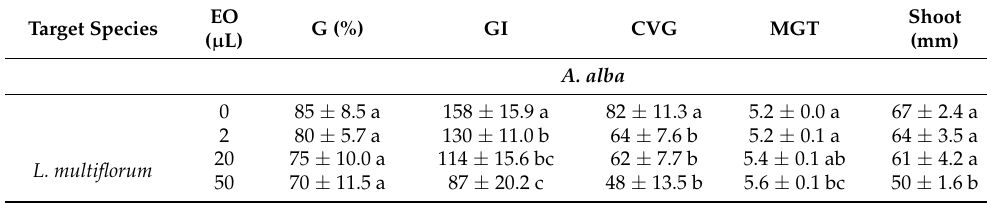
Table 3. Germination and growth values of two receiver species under the phytotoxic effects of different doses of EOs (vapor phase) in pre-emergence